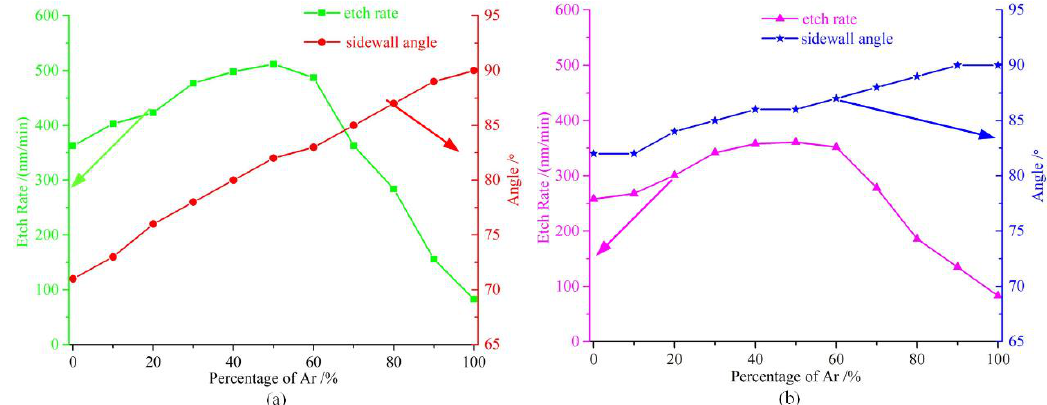
Figure 1. ( a ) The test results of the etching rate and sidewall angle versus the C 4 F 8 percentage; ( b ) the test results of the etching rate and sidewall angle versus SF 6 percentage.